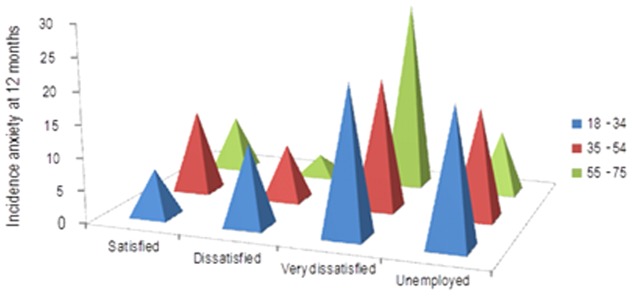
Incidence of anxiety by age and dissatisfaction at work.